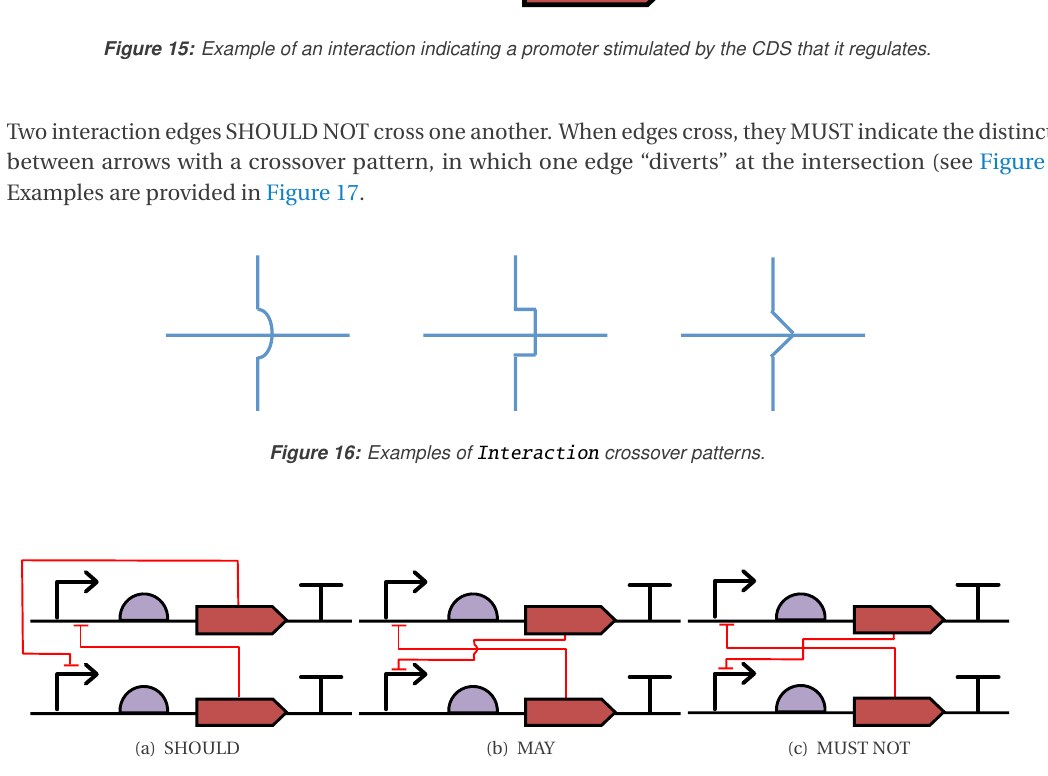
Figure 17: Examples of recommended, allowed, and forbidden relationships between two interactions in a mutual repression system: (a) non-crossing is recommended, (b) using a crossover pattern is allowed, but (c) crossing without a crossover pattern is forbidden, since the relationship between the two edges is